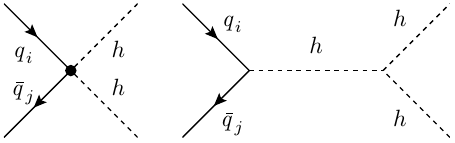
Figure 4 . The dominant Feynman diagrams for the quark anti-quark annihilation ( q ¯ qhh ) production of Higgs pair, via the SMEFT operator O qφ